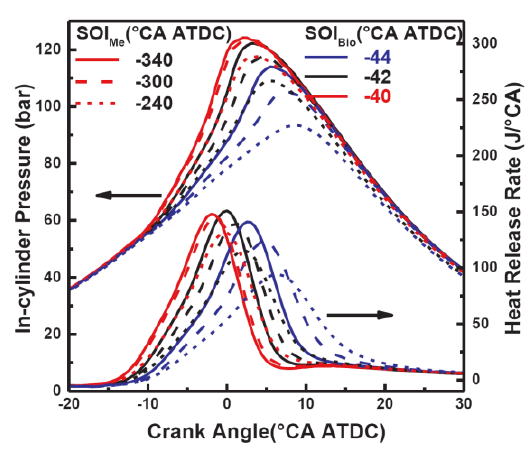
Fig. 17. Effects of fuels injection timings on the in-cylinder pressure and heat release rate (methanol energy ratios = 30%) (reproduced from [18])